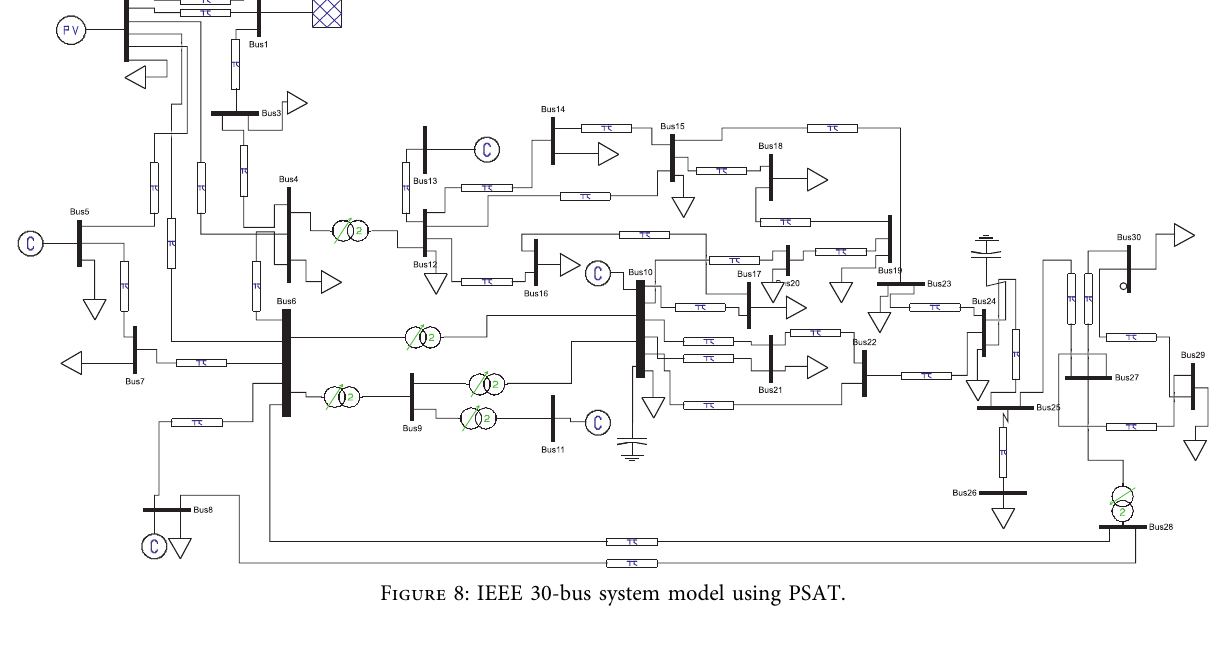
Figure 8: IEEE 30-bus system model using PSAT.